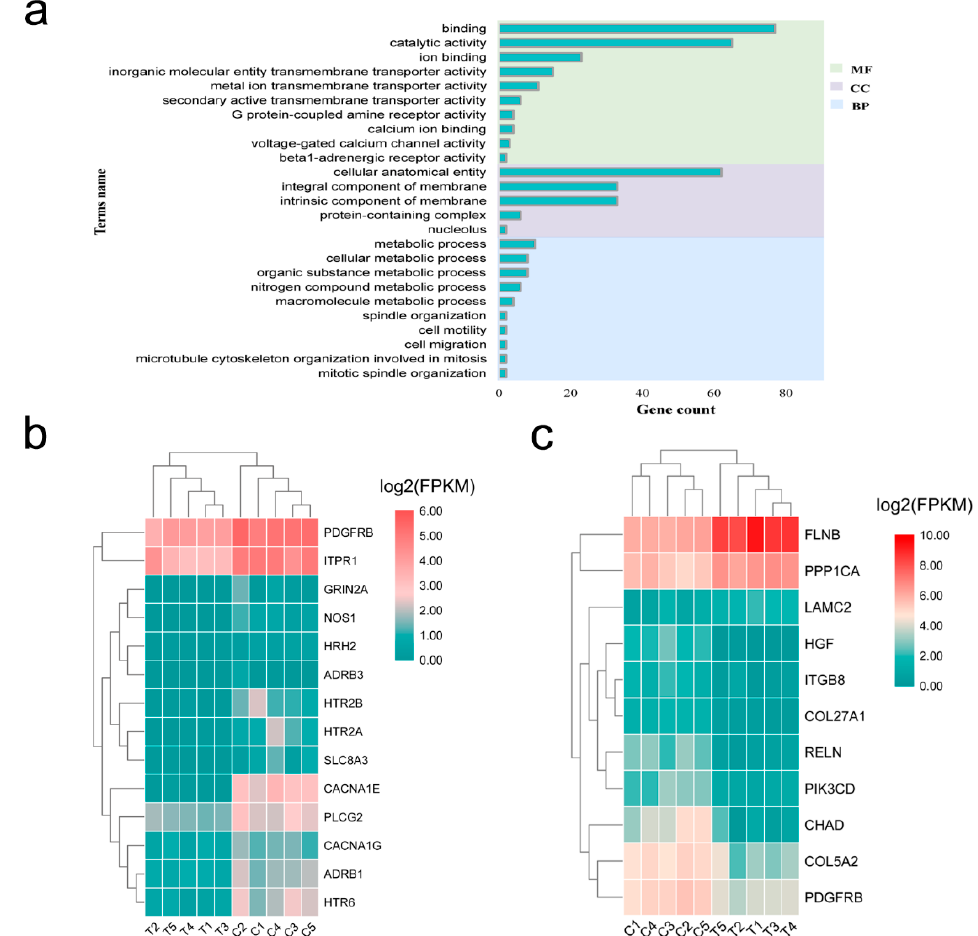
Figure 6. Functional enrichment analysis of the mRNA targets of the differentially expressed miRNAs between the lactating and non-lactating pigeon crops. ( a ) GO analysis; ( b ) Heatmap displaying the lactation-related genes identified in calcium signaling pathway; ( c ) Heatmap displaying the lactation-related genes identified in focal adhesion pathway. C, non-lactating group; T, lactating group.